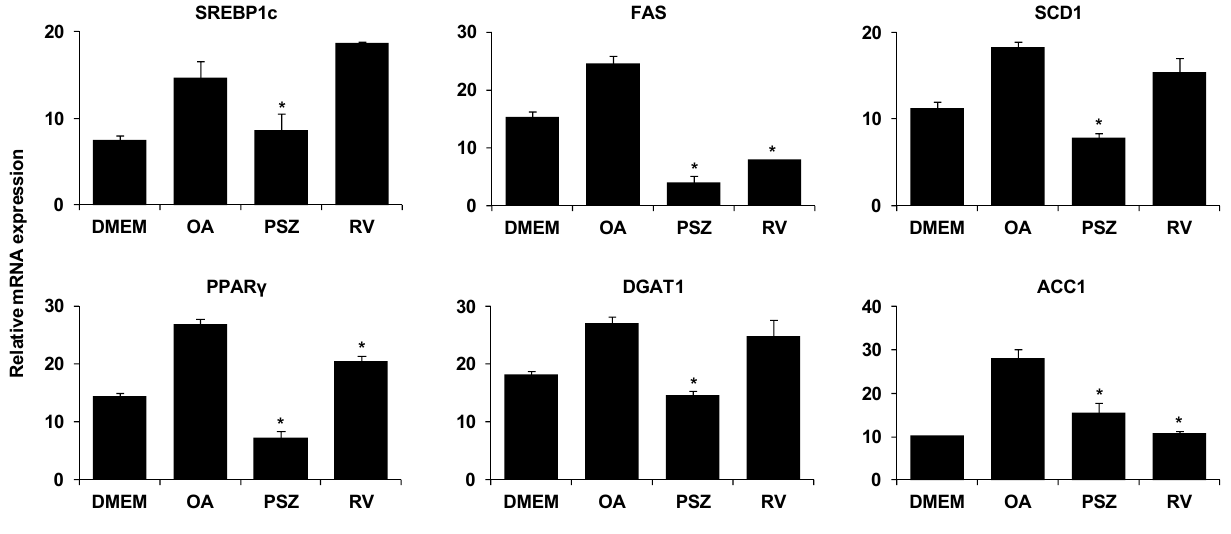
Figure 3. Effects of Pinus densiflora Sieb. et Zucc. (PSZ) on expression of lipogenesis genes in HepG2 cells stimulated with oleic acid (OA). HepG2 cells were treated with 100 μ g/mL PSZ and OA. After treatment for 24 h, RNA was isolated and reverse-transcribed for RT-PCR analyses using the primers described in Table 1. Results are the mean ± SEM from three independent experiments. * p < 0.05 compared with the OA group. DMEM, control group; OA, oleic acid-treated group; PSZ, OA +